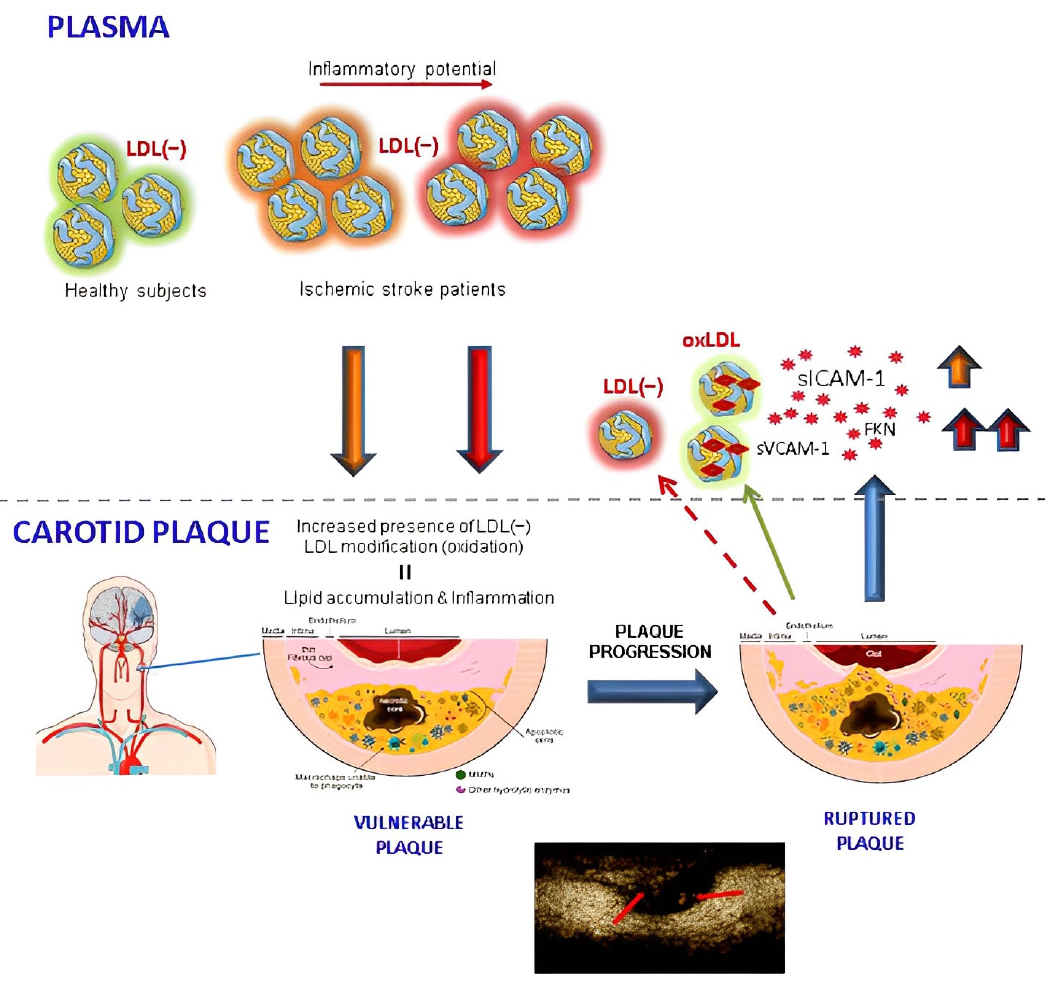
Figure 6. Role of LDL( − ) in ischemic stroke associated with atherosclerosis. Before the stroke event, subjects with a high susceptibility to developing carotid atherosclerosis show a high percentage of LDL( − ) with inflammatory properties. At first, LDL( − ) contributes to carotid plaque formation and promotes the progress of the lesion by the sustained induction of inflammation and lipid